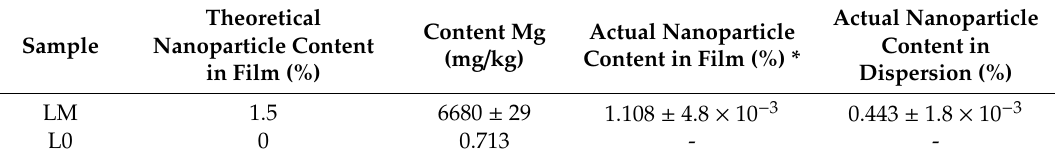
Table 5. Determination of nanoparticles content in coating film and aqueous dispersion by ICP–